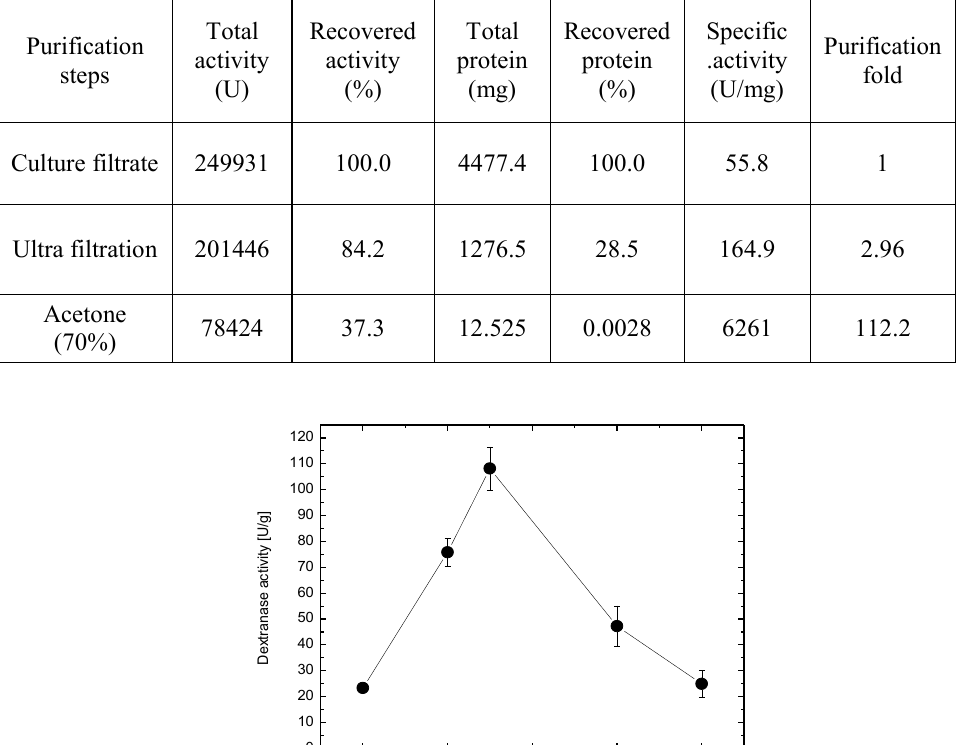
Table1. Partial purification steps of Bacillus subtilis NRC-B233b dextranase.